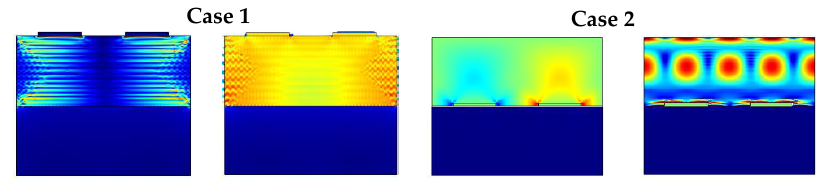
Figure 14. Electric field mode and current density mode of the phonon piezoelectric device.